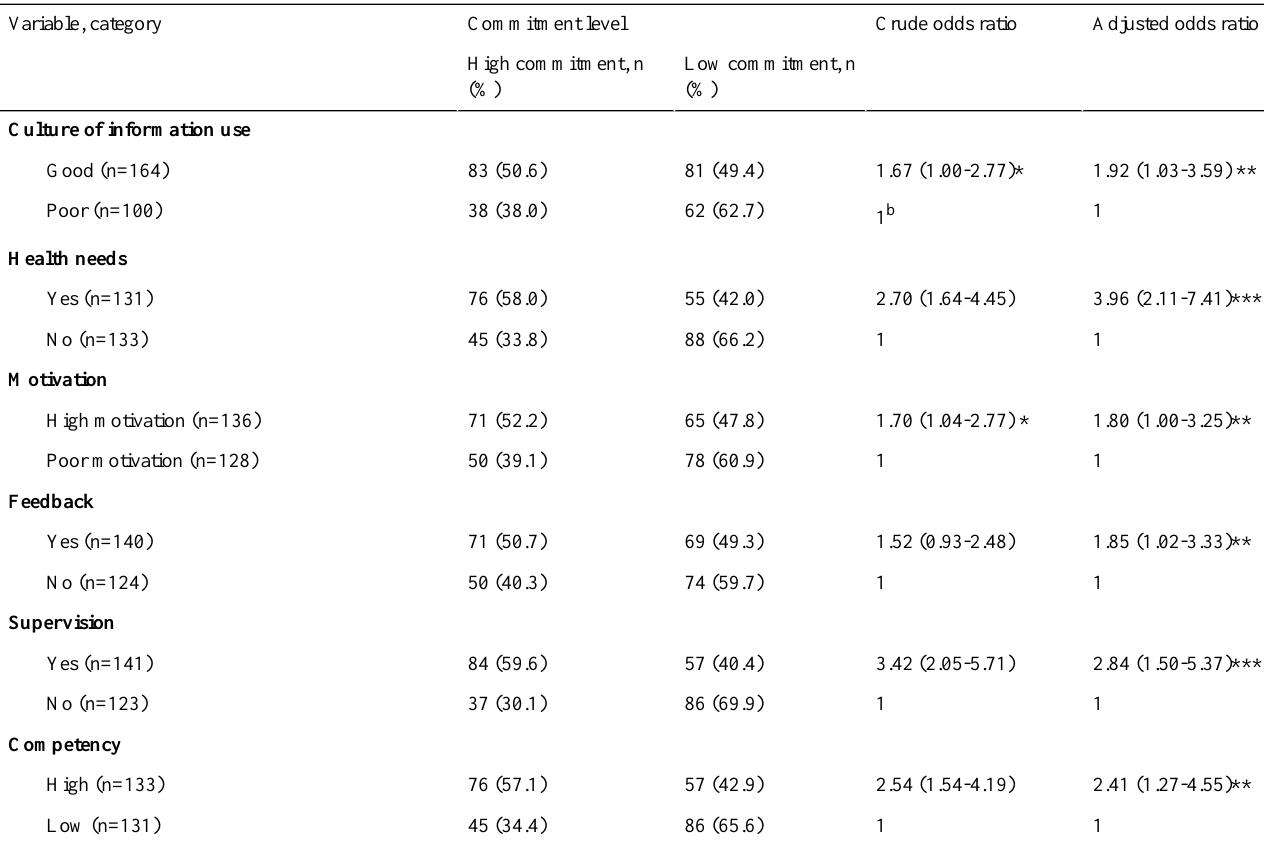
Table 3. Factors associated with the level of commitment to use district health information system 2 data among performance monitoring team members at health facilities in the Ilu Aba Bora zone, Oromia region in 2020 a